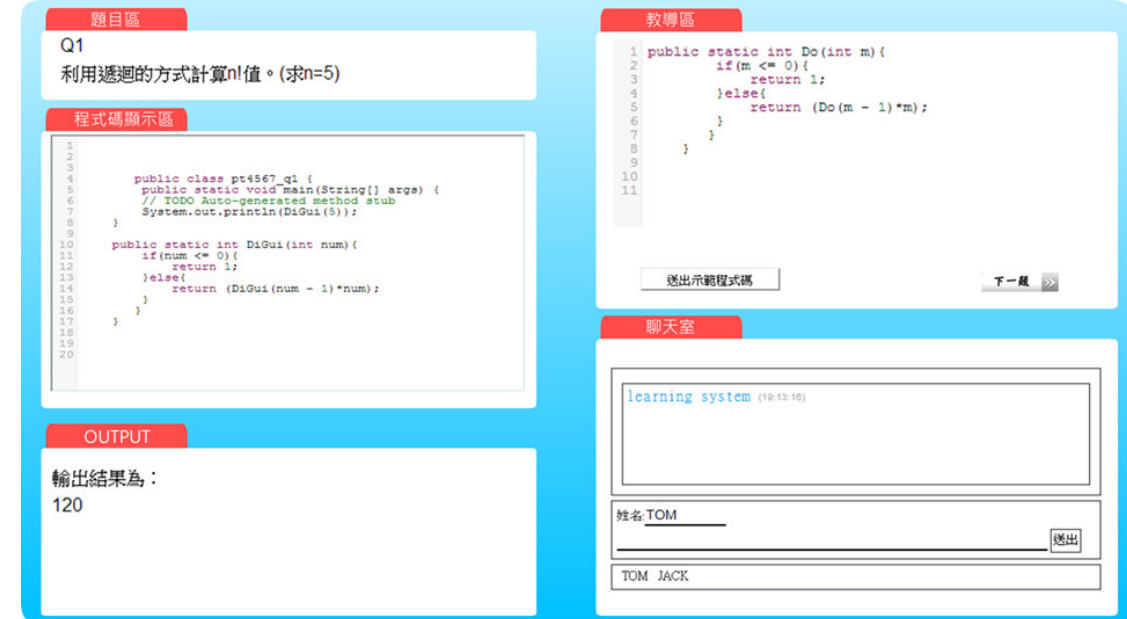
Figure 4. System frame−Experimental group A (tutor).